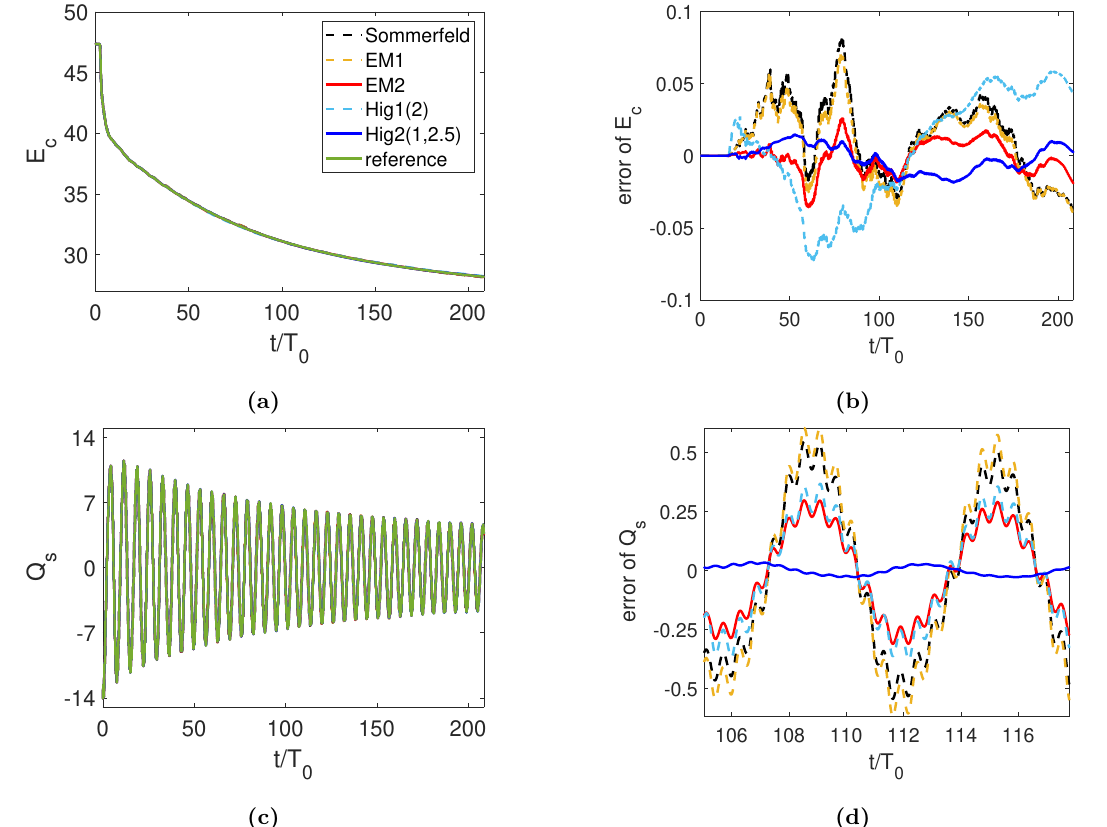
Figure 7. Comparisons of simulations with various absorbing boundary conditions (ABCs) in the initial relaxation phase. The left two plots are from the reference simulation, and the right two plots are the deviations of the simulations with various ABCs from the reference simulation. The various ABCs are defined in the text below eq. (2.14), and energy E ( t ) and charge Q ( t ) are defined in c s section 2.1. The reference simulation is obtained by using a large lattice such that the radiation has not reached the boundaries in the run. Dashed lines represent first-order ABCs and solid lines represent second-order ones. We see that second order ABCs generally perform better than the first order ABCs, and the Hig2(1,2.5) ABC has the best behavior with regard to eliminating the initial relaxing radiation. T = 2 π/m is roughly the oscillation period of the field φ 0